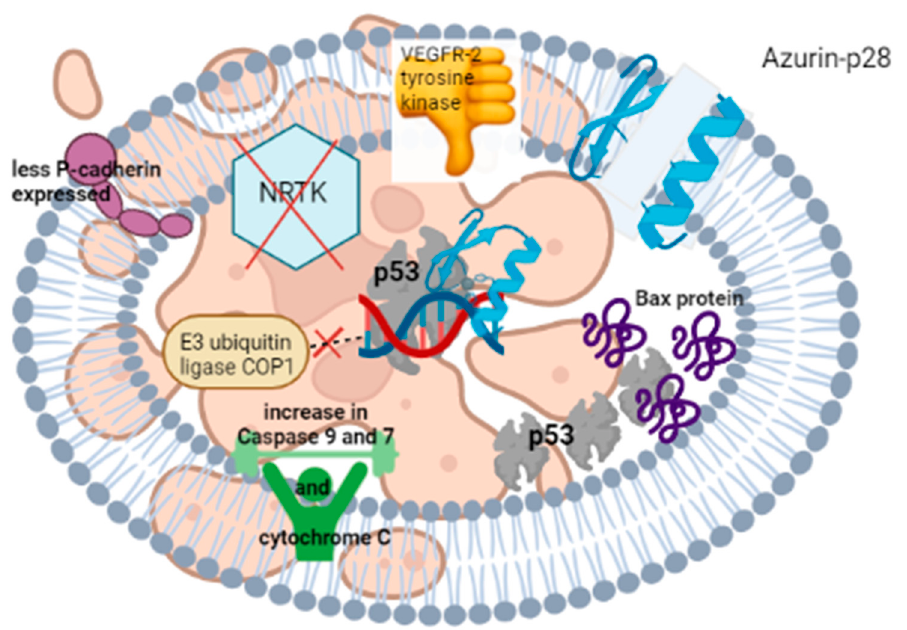
Figure 6. Mode of action of Azurin. Once inside a cancer cell, azurin attaches to the DNA-binding domain of the tumour-suppressor protein p53 (middle of presentation) and prevents binding of the latter to E3 ubiquitin ligase COP1, resulting in an increase in cytoplasmic p53 levels. Cell growth is repressed, and cells are destroyed by apoptosis. Azurin also interferes with non-receptor tyrosine kinase (NRTK) signalling pathways. Bax protein (a central cell death regulator) and cytochrome C levels increase, and caspases 9 and 7 are activated. VEGFR-2 tyrosine kinase activity is reduced, preventing the formation of new blood vessels and the expression of P-cadherin. Prepared using BioRender (https://biorender.com/, accessed on 12 May 2022).